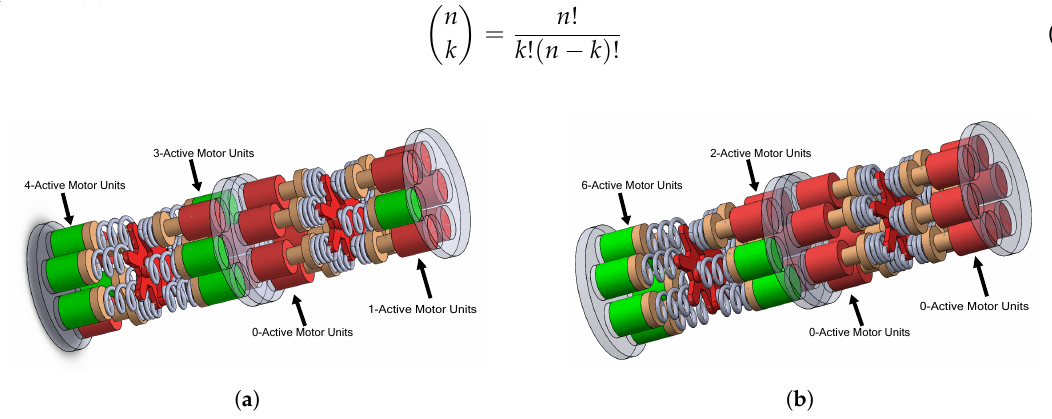
Figure 6. Different activation patters while maintaining same activation level: ( a ) eight motor units active (highlighted in green) over two actuation units—shorthand written as a vector [4 3 0 1]; and ( b ) eight motor units active (highlighted in green) over two actuation units—Shorthand written as a vector [6 2 0